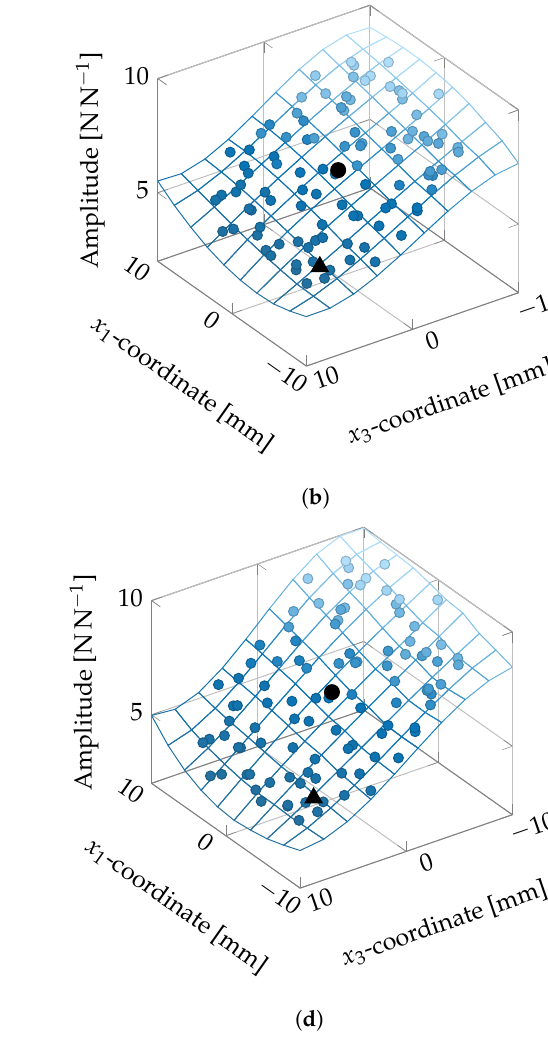
Figure 10. Metamodels for the influence of the x 1 -, x 2 - and x 3 -coordinates derived from 100 design variants by using Direct and Box Morphing. Original design at ( 0mm,0mm,0mm ) T and an amplitude of 6.68NN − 1 , highlighted by a black dot. Manually optimized design at ( − 5.77mm,5.77mm,5.77mm ) T , highlighted by a black triangle. ( a ) Direct Morphing, metamodel for x 1 - and x 2 -coordinates with R 2 = 0.94, manually chosen optimum at 5.8NN − 1 . ( b ) Direct Morphing, metamodel for x 1 - and x 3 -coordinates with R 2 = 0.90, manually chosen optimum at 4.7NN − 1 . ( c ) Box Morphing, metamodel for x 1 - and x 2 -coordinates with R 2 = 0.95, manually chosen optimum at 5.8NN − 1 . ( d ) Box Morphing, metamodel for x 1 - and x 3 -coordinates with R 2 = 0.94, manually chosen optimum at 4.3NN − 1